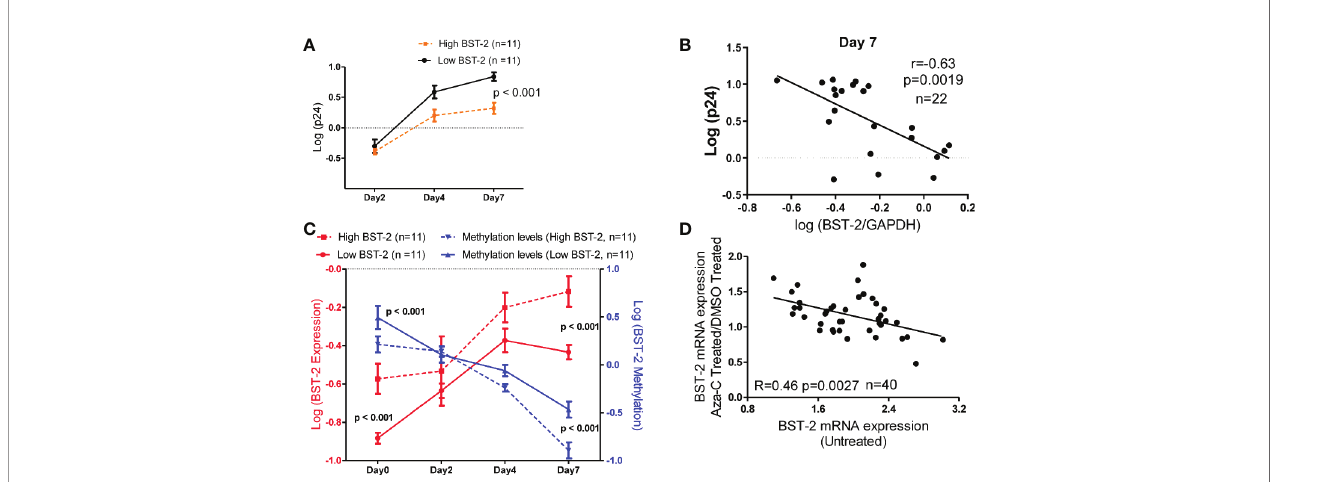
FIGURE 5 | BST-2 mRNA expression and methylation levels correlate in an in vitro viral replication assay, and treatment with a DNA hypo-methylation drug increases BST-2 mRNA expression levels. (A) Individuals were pre-selected based on BST-2 expression levels for a HIV replication assay. PBMCs from HIV negative donors (n=22) were infected with HIV IIIB viral strain, the amount of virus present was determined by measuring the p24 antigen using an ELISA assay. Measurements of p24 for both high and low BST-2 donors were taken at days 2, 4 and 7. Donors with higher BST-2 levels (dotted line) had lower level of p24, while donors with lower BST-2 levels (solid line) had signi fi cantly higher p24 levels (p<0.001). (B) A negative correlation was observed when comparing the HIV replication levels against the BST-2 mRNA levels at day 7 from the in vitro HIV infection assay (r=-0.63, p=0.0019). (C) mRNA and DNA were used to measure BST-2 expression (red) and methylation levels (blue), respectively, from high and low BST-2 donors (n=22) at four time points during the viral replication assay, days 0, 2, 4 and 7. Within high BST-2 donors, we fi nd high expression (red dotted line) associated with lower methylation (blue dotted line) and vice versa for low BST-2 levels, where low expression (red solid line) associated with higher methylation (blue solid line). (D) PBMCs from HIV negative donors (n=40) were split into three subsets; the fi rst subset was treated with a DNA methyltransferase inhibitor that causes hypomethylation (5 ’ -Aza-CdR), while the second subset was treated with DMSO. Both subsets were incubated for 24 hours. BST-2 mRNA expression from 5 ’ -Aza-CdR and DMSO treated cells were compared and plotted as a fold change against BST-2 mRNA from an untreated time point (third subset), a signi fi cant correlation was observed (R=-0.46,